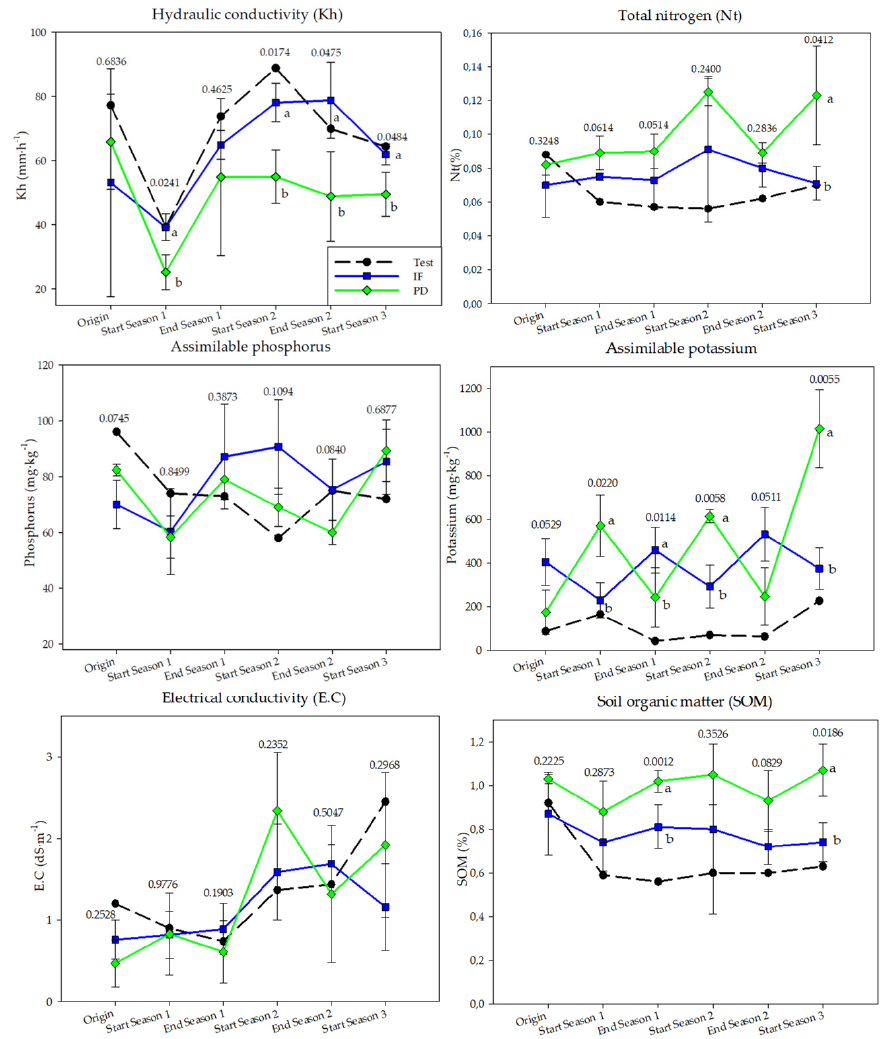
Figure 6. Soil physicochemical parameters in the three years of study (September–April cycles) as a function of crop nutrition. Inorganic fertilization (IF; n = 3); tomato plant debris (PD; n = 3); no fertilization (test; n = 1). Values (mean ± standard deviation). Different letters indicate significant differences between IF and PD ( p ≤ 0.05, Student’s t-test).